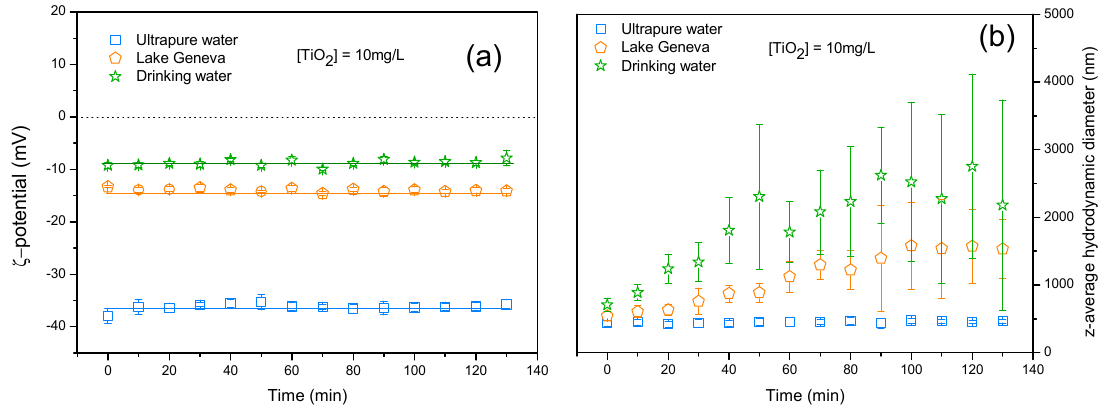
7 of 14 Figure 4. (a) ζ potential and ( b) z-average hydrodynamic diameter variation of TiO 2 as a function of time in ultrapure water at pH = 7.0 ± 0.1 and mineral waters at their natural pHs. TiO 2 surface charge is found to be reduced and neutralized in mineral waters hence resulting in TiO 2 aggregation. By considering MWs, a systematic decrease in ζ potential, i.e less negative values, is observed, which is found to be proportional to the mineral water hardness. The presence of divalent ions, such as Ca 2+ and Mg 2+ , is found here to strongly modify the stability of negatively charged TiO 2 NPs via specific adsorption. As shown in Figure4a, at a low concentration of divalent ions (MW1), TiO 2 NPs are found to be less stable than in ultrapure water, which is in good agreement with their surface charge ( − 16 ± 1 mV). As a result, a continuous increase of aggregate size is observed within the